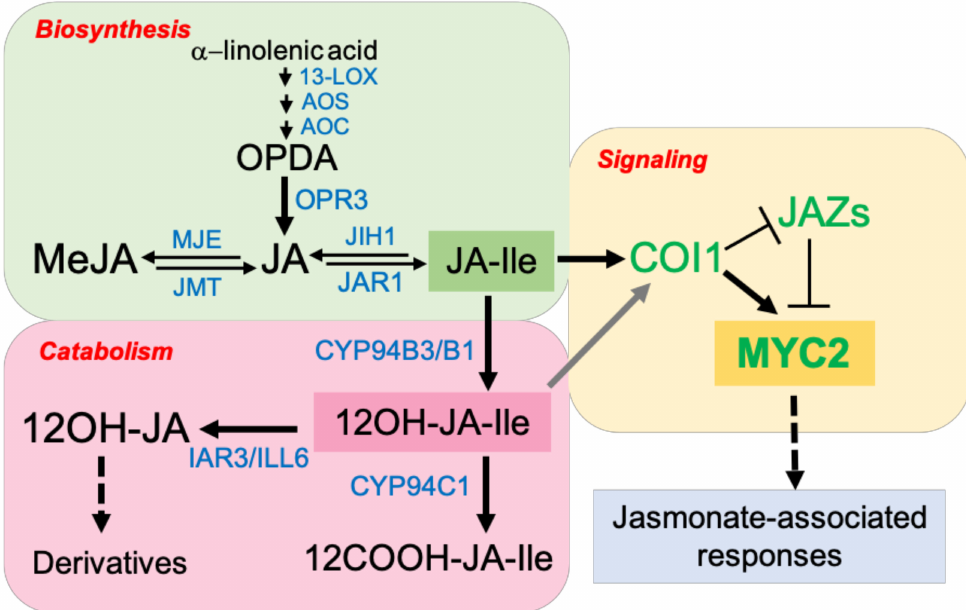
Figure 1. Overview of the jasmonate (JA) pathway including the major molecular players involved in biosynthesis, signaling, and catabolism. Black, blue, and green fonts show the main metabolites, enzymes, and proteins, respectively, for each section of the pathway. Scheme made based on [49,58,80]. For more details, see the